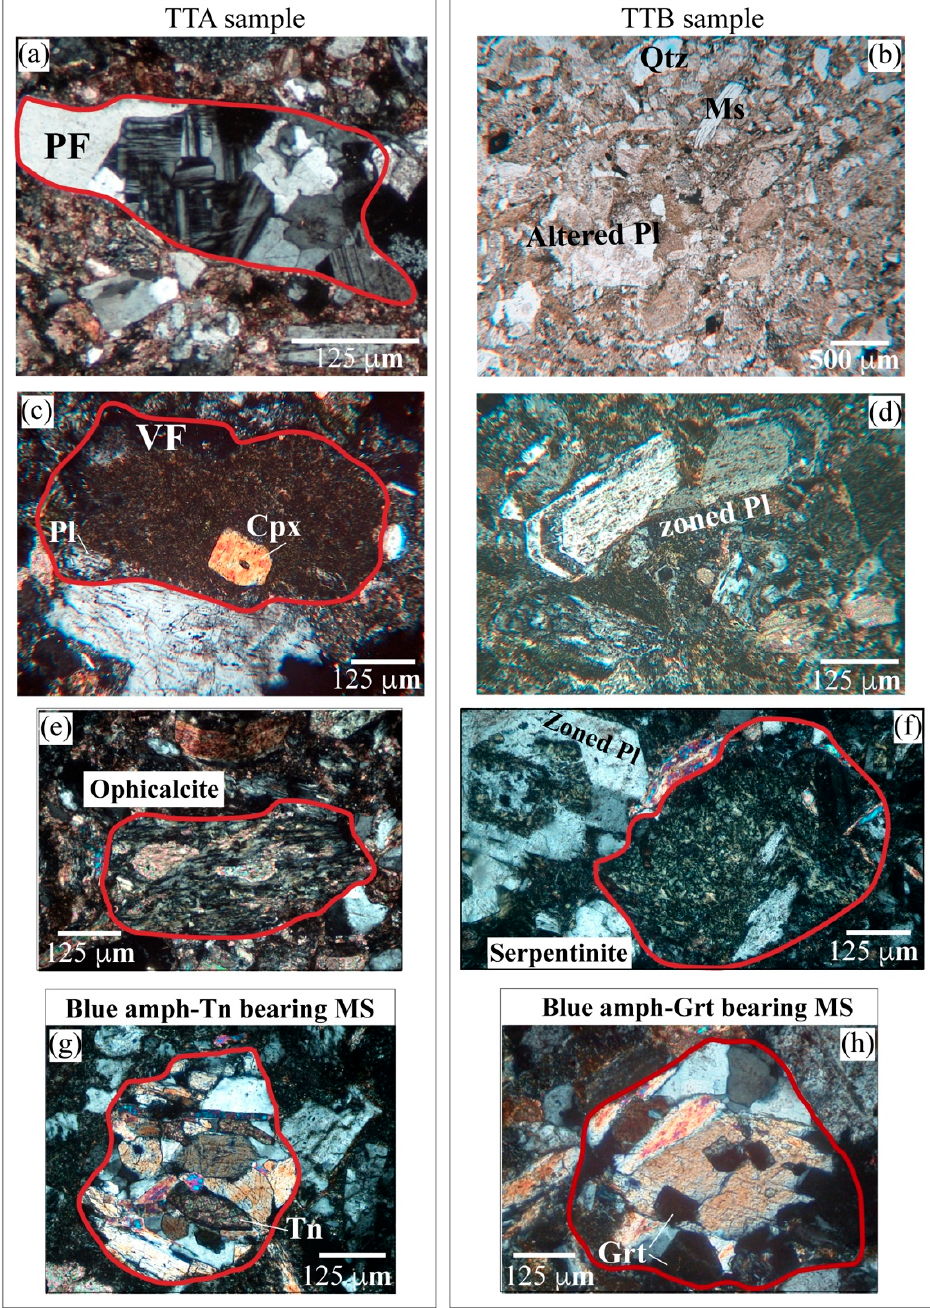
Figure 4. Microphotographs of the coarse-grained TTA sample (to the left): ( a ) granitic fragment, ( c ) volcanic fragment with phenocrysts of plagioclase and clinopyroxene; ( e ) ophicalcite fragment; ( g ) blue amphibole-bearing micaschist with titanite. Microphotographs of fine-grained TTB sample (to the right): ( b ) abundant pseudo-matrix; ( d ) volcanic zoned plagioclase and alteration products in pseudo-matrix; ( f ) serpentinite fragment; ( h ) blue amphibole-garnet-bearing micaschist. Abbreviations: PF, plutonic fragment; VF, volcanic fragment; Ms, muscovite; Pl, plagioclase; Qtz, quartz; Tn, Titanite; Grt, Garnet; MS, micaschist.